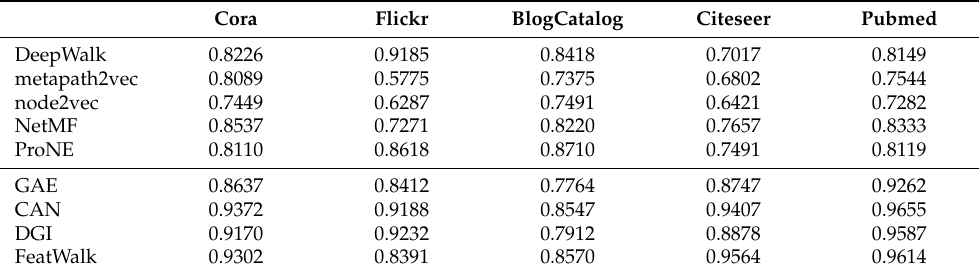
Table 11. Results in Task 2 using TPE to tune hyperparameters, in terms of ROC